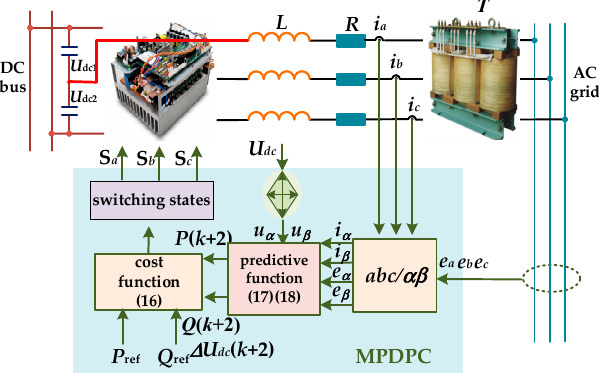
Figure 5. Model predictive direct power control (MPDPC) structure for fault-tolerant BVSC with leg fault of phase a.